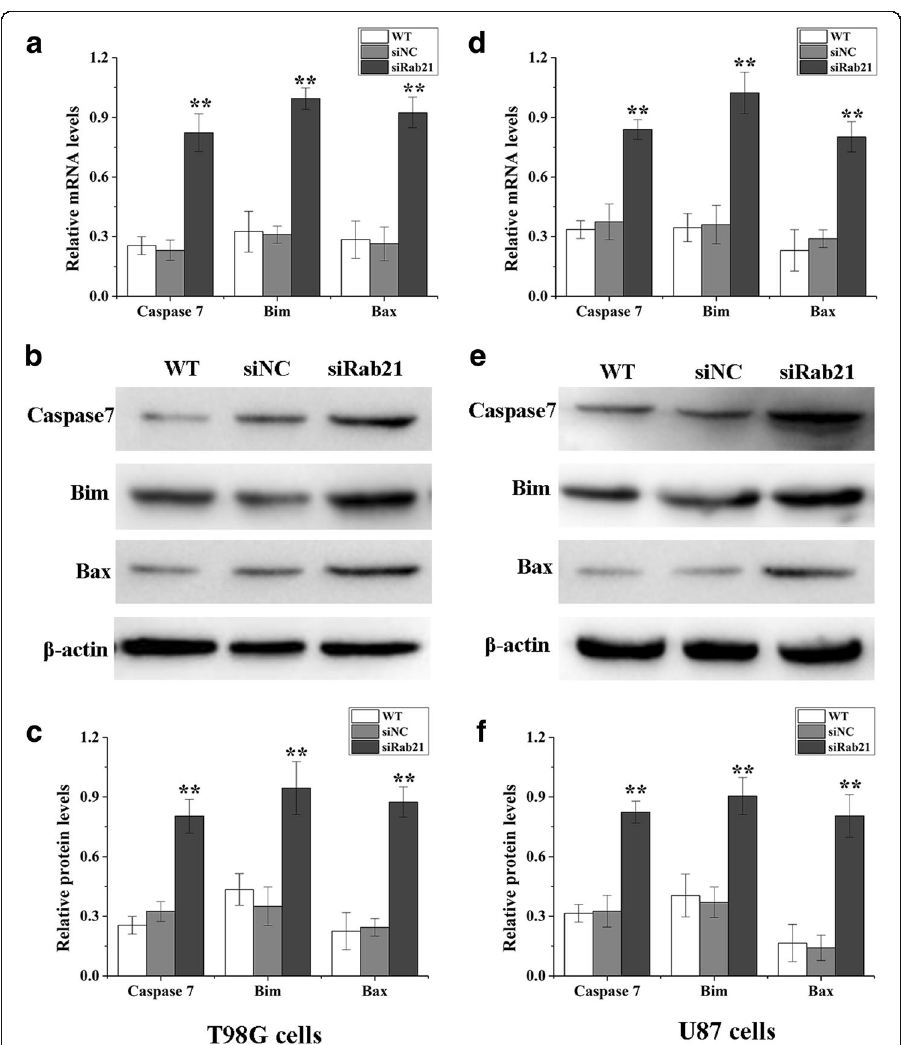
Fig. 6 Effects of Rab21 siRNA on the expression of apoptosis-related proteins. After transfection with Rab21 siRNA for 48 h in T98G ( a – c ) and U87 ( d – f ) cells, the mRNA ( a , d ) and protein ( b , c , e and f ) levels of apoptosis- related proteins were determined using qRT-PCR and western blot,